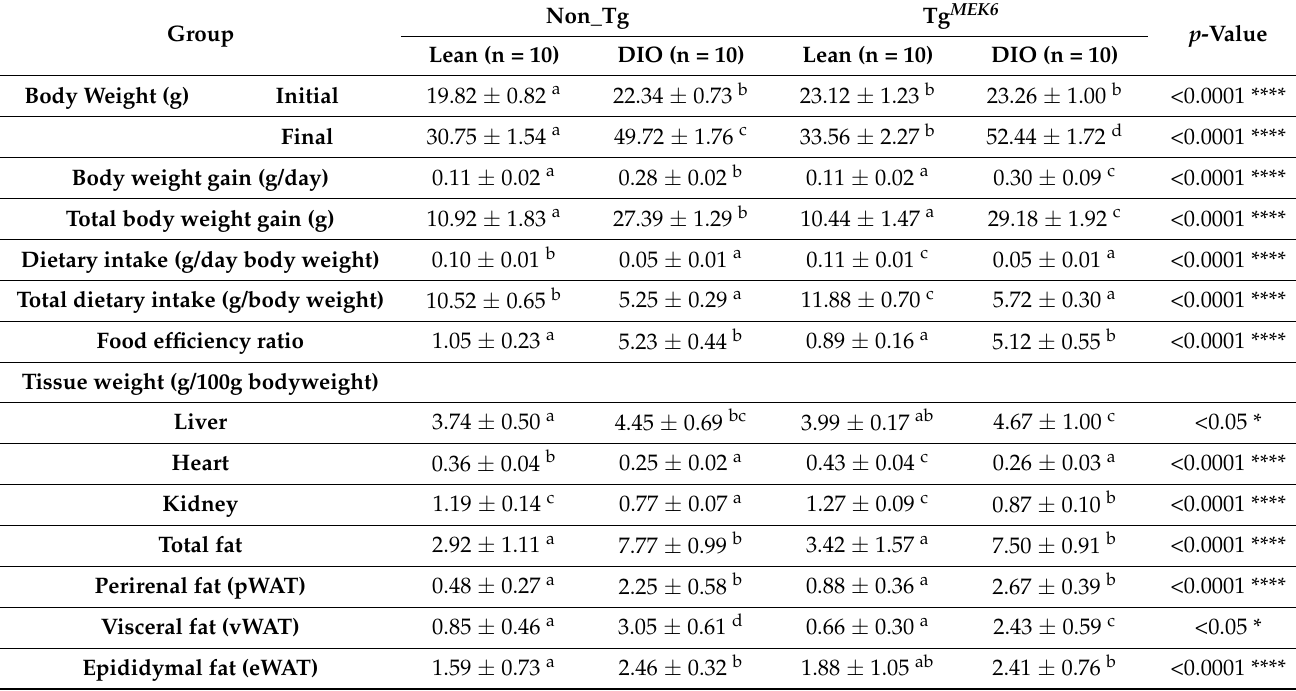
Table 1. Body weight, total body weight, total food intakes, food efficiency and tissue weight.